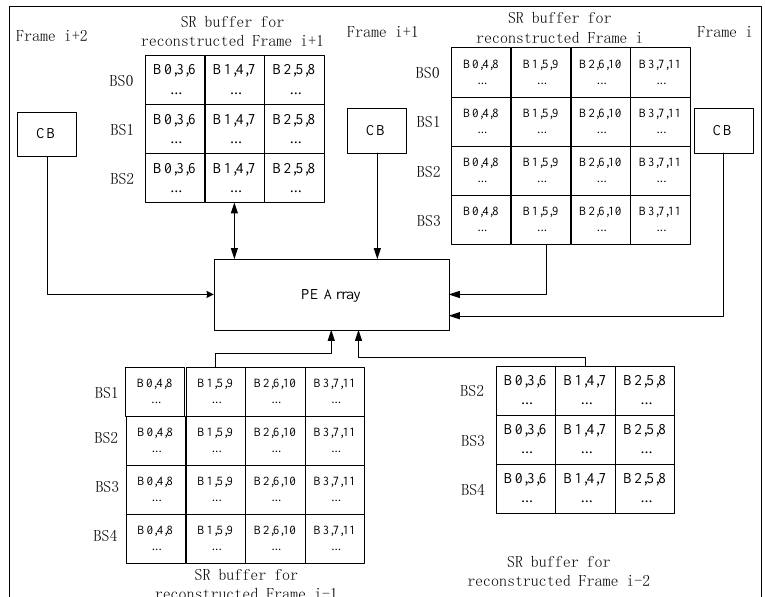
Figure 16. Architecture of Inter-C for VC-MRME.